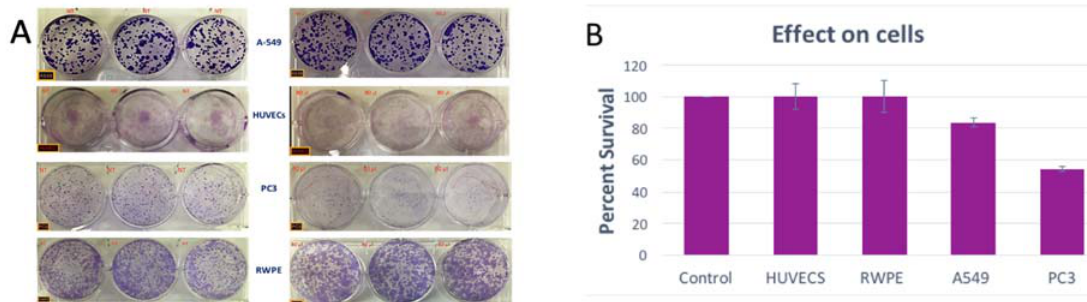
Figure 3. ( A ) Clonogenic survival assay results showing the e ff ect of isolated plant extract on normal and cancer cells; ( B ) percent survival relative to controls. A549 = adenocarcinomic human alveolar basal epithelial cells; HUVECS = Human umbilical vein endothelial cells; PC3 = human prostate cancer cells; RWPE = normal prostate epithelial cell